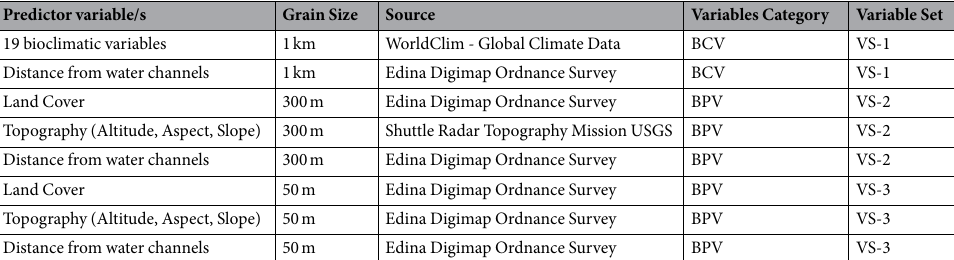
Table 2. Allocation of predictor variables to ‘variable categories’ and ‘variable sets’. Acronyms BCV, BPV, VS-1, VS-2 & VS-3 refer to Bioclimatic Variables, Biophysical Variables, Variable Set 1, Variable Set 2 & Variable Set 3